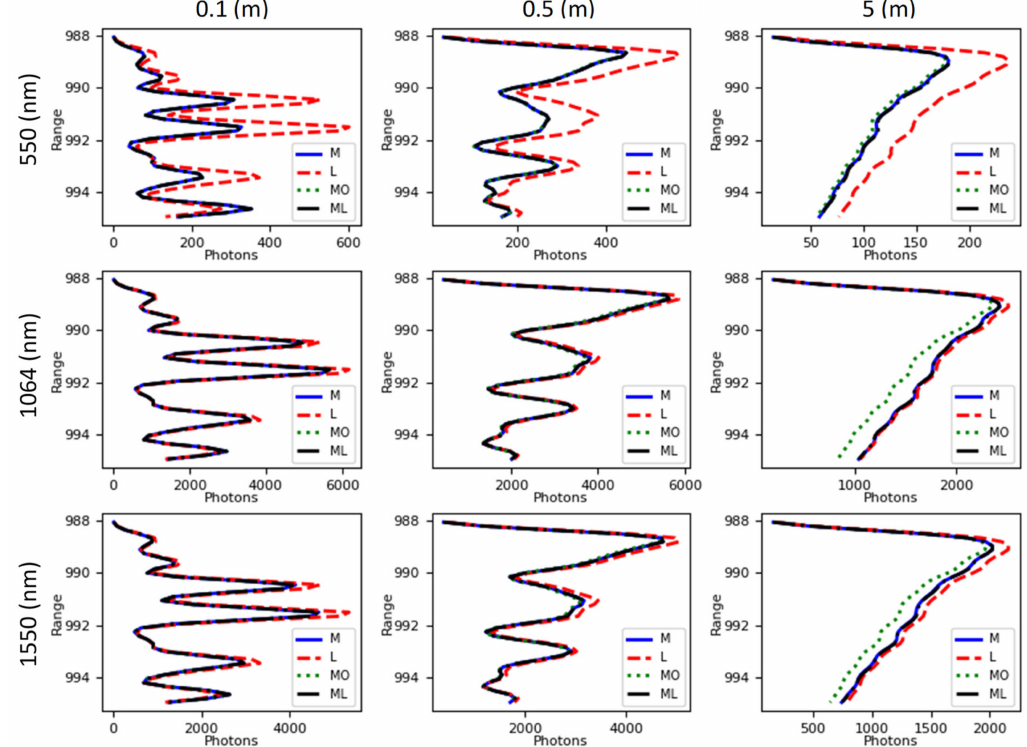
Figure 15. Waveform comparison plots for each leaf BSDF type at the zero zenith angle and spherical leaf angle distribution of leaves. Plots are shown for the three beam footprint diameters of 0.1, 0.5, and 5 m (left-to-right), and the three wavelengths of 550, 1064, and 1550 nm (top-to-bottom). The legend symbols for the four leaf BSDF types are “M” for model, “L” for Lambertian, “MO” for model reflectance and no transmittance, and “ML” for model reflectance and Lambertian transmittance. In order to display more detail, the last five meters of range are excluded, thus only displaying the canopy